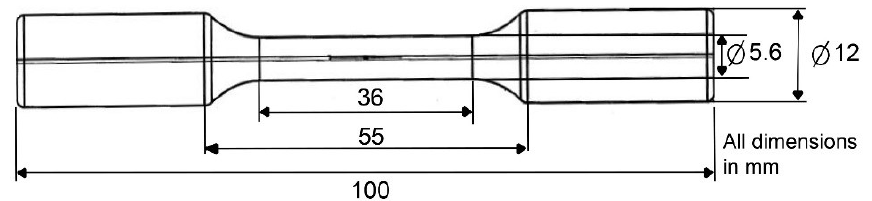
Figure 1. Schematic diagram of the tensile specimen used in this study.